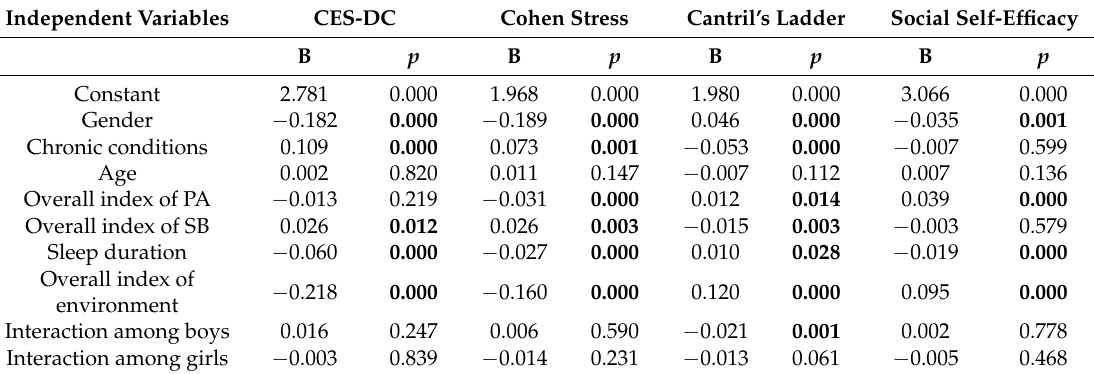
Interaction among girls 0.468 * Girls and healthy students are reference category; other independent variables are continuous covariates; 3-way interaction: gender x overall index of environment x overall index of PA; B—regression parameter. Bolded: p -values indicate statistically significant